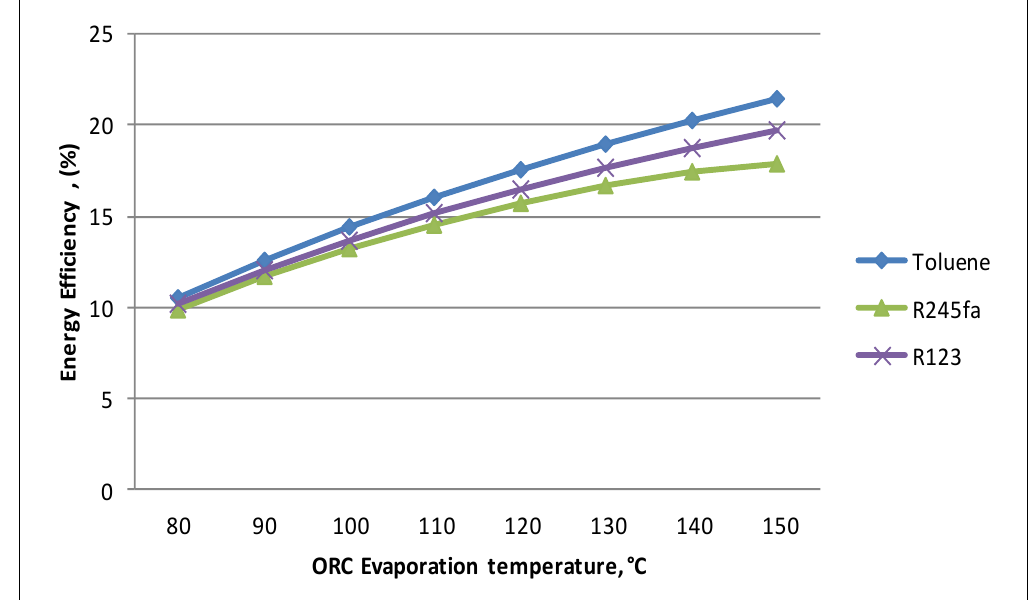
Figure 4. Variation of Energy Efficiency with ORC evaporation temperature according to the studied working